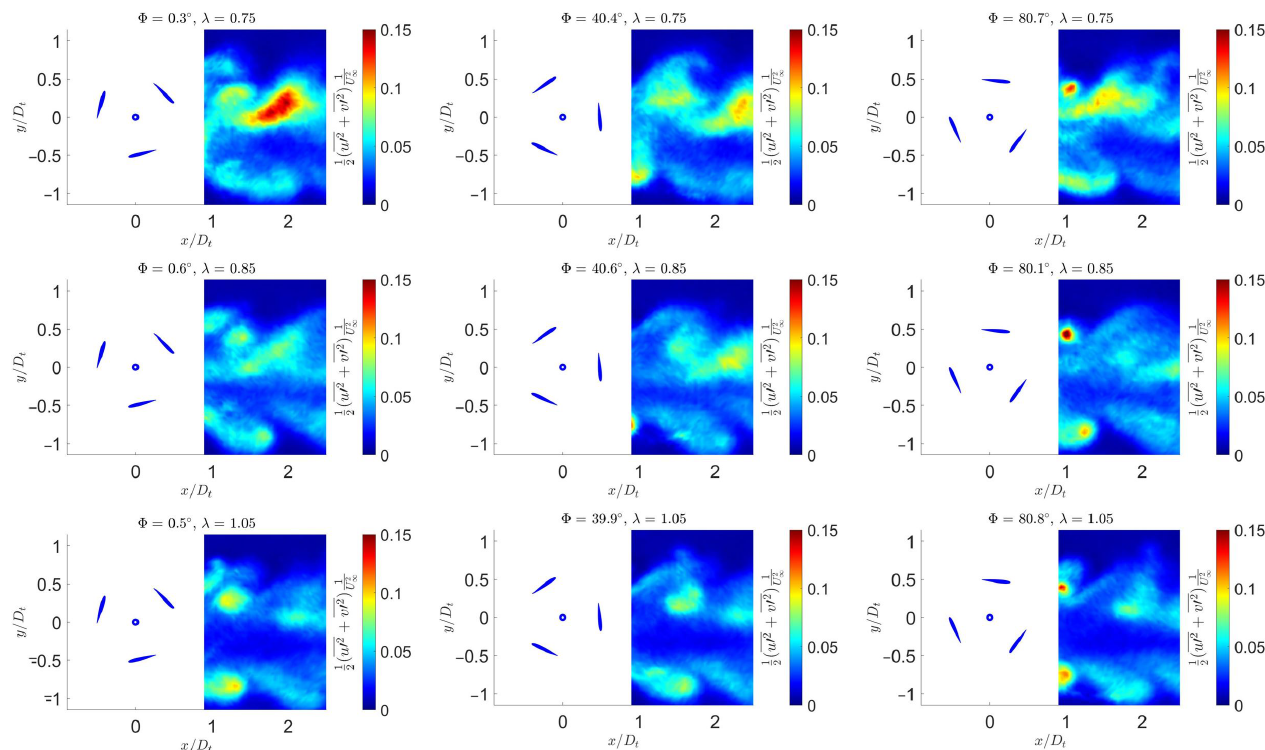
Figure 18. The random component of the phase-averaged kinetic energy of the flow behind turbine T2 at various phase angles and tip–speed ratios. The blue circle displays turbine T2 rotation